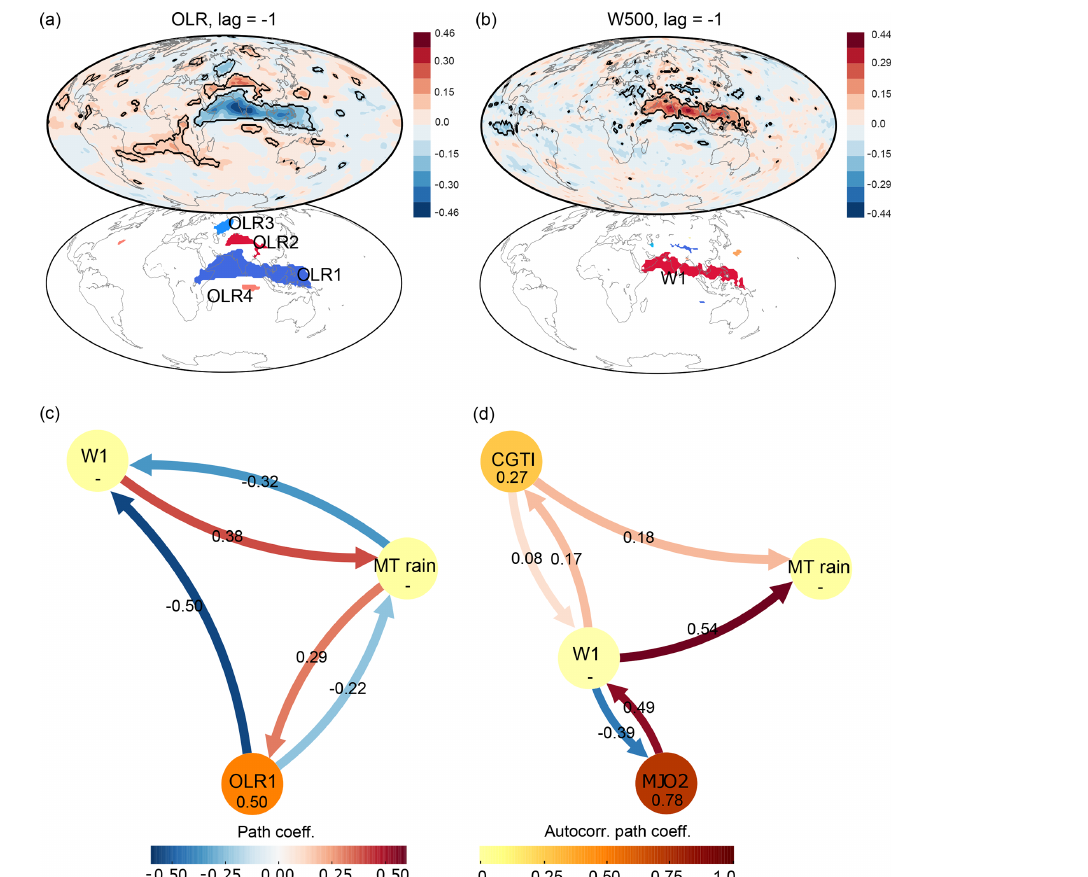
Figure 6. Tropical causal interactions of ISM. Panel (a) shows the correlation map of weekly MT rainfall with the global OLR field at 1-week lead time (top) and the causal precursors identified via RG-CPD (bottom) for the period 1979–2017. Regions with correlation values with a p value of p < 0 . 05 (accounting for the effect of serial correlations) are shown by black contours. (b) As for panel (a) but for the W500 field. Panels (c) and (d) show the CEN built with W1, OLR1 and MT rainfall and MT rainfall, W1, CGTI and MJO2, respectively. The strengths of causal links expressed by the standardized regression path coefficients and autocorrelation path coefficients are shown above the arrows and inside the circles, respectively. All links have a lag of 1 week. Only causal links with corrected p < 0 . 05 are shown. See the main text for